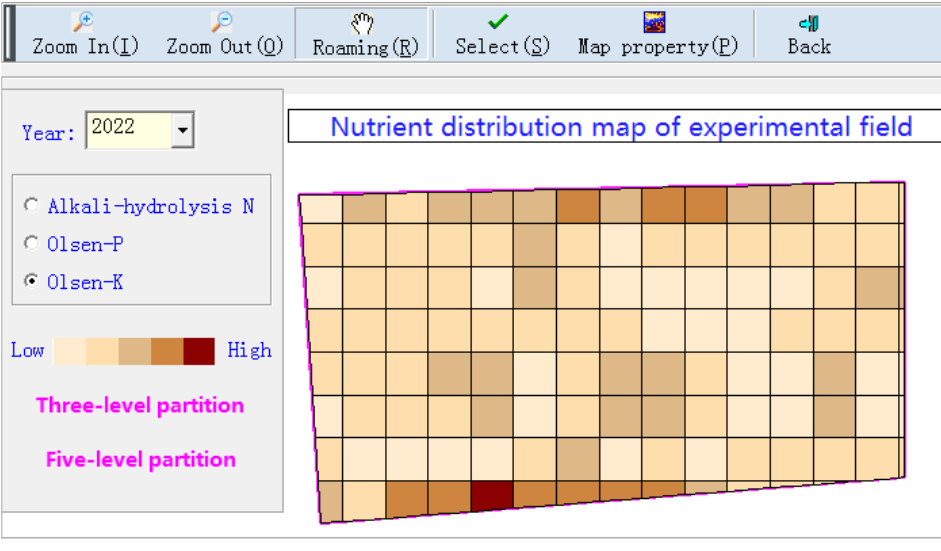
Figure 8. Distribution map of soil available potassium in the five-level partition.